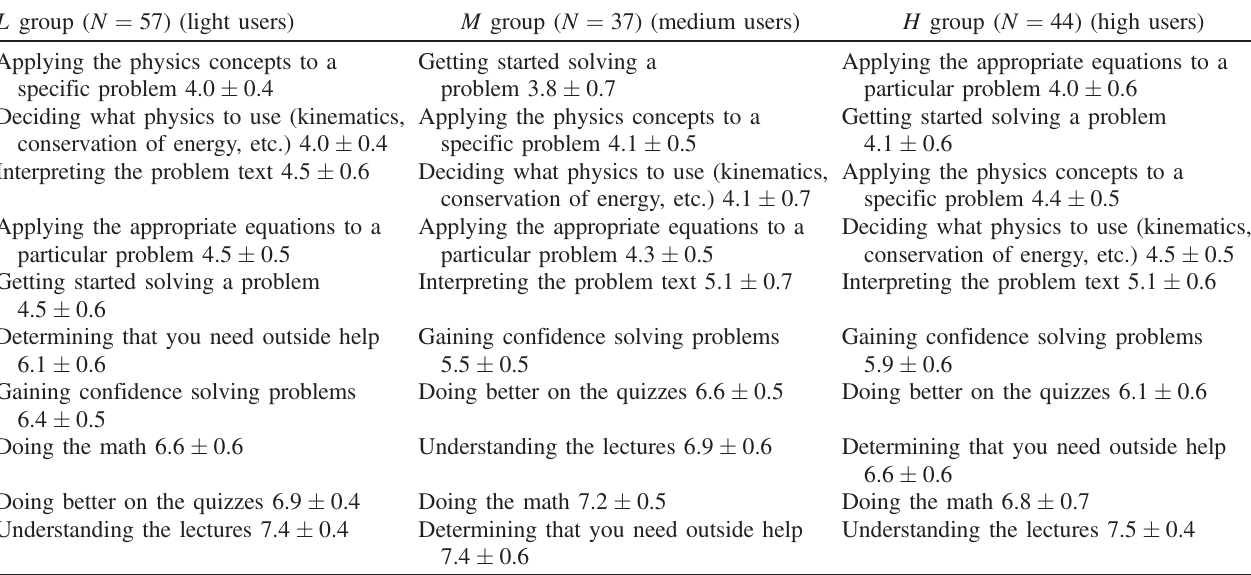
TABLE X. Results from a spring 2013 end-of-semester survey question asking students to rank (with no ties), ten ways in which the coaches were useful to them in order from most (1) to least useful (10). Lower numbers are better. L group ( N ¼ 57 ) (light